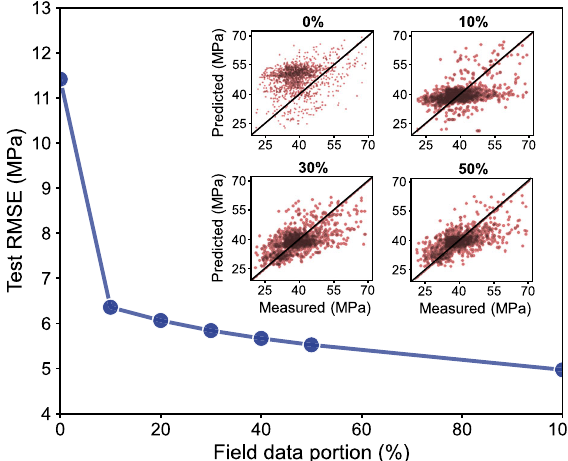
Fig. 8 Effect of fi eld data portion in a training dataset (containing laboratory and fi eld data) on fi eld compressive strength predic- tion 97 . Insets show the comparisons between measured and predicted strength values at the replacement percentages of 0%, 10%, 30%, and 50% by fi eld data (transparency of the data points represents their frequency). RMSE, root mean square error. Figure adapted with permission from ref. 97 ,